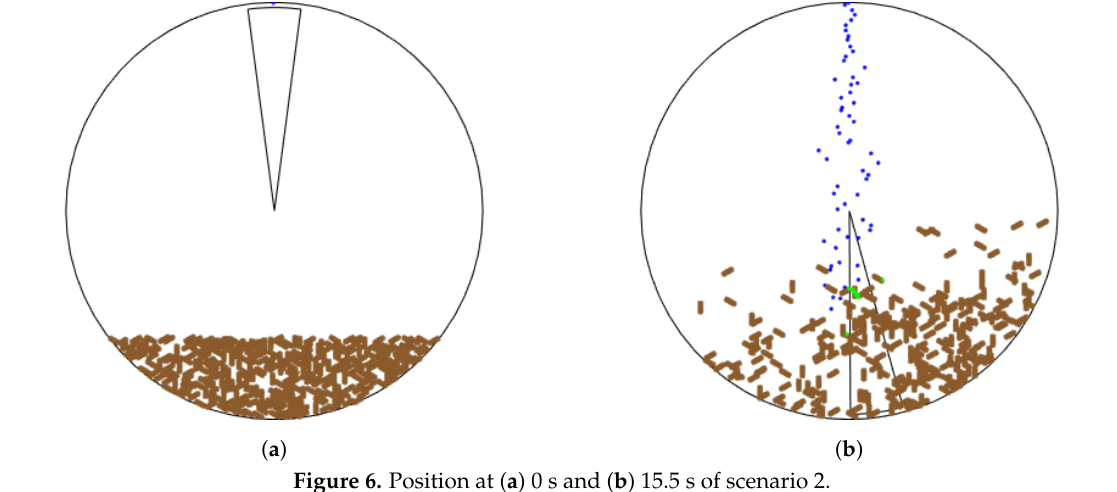
Figure 6. Position at ( a ) 0 s and ( b ) 15.5 s of scenario 2.